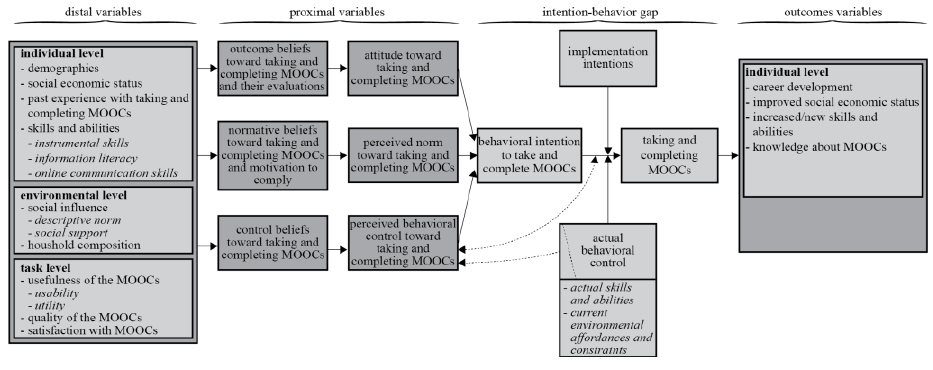
Figure 1 : Research model of the MOOCKnowledge project Background variables are usually referred to as distal variables whereas the different variables that directly influence intention are referred to as proximal variables. Distal variables in our model exist on an individual level, a social level, and a task level. These are for example demographic data, the socio-economic status of the participants, their lifelong learning profile, previous experiences with open online courses and IT competences. The reasoned action approach identifies attitude, perceived norm, and perceived behaviour control (i.e., self-efficacy) as proximal variables as they directly predict behavioral intention. Attitude is the person’s favourable or unfavourable position as regards taking a MOOC. Attitude is generally formed by the outcome beliefs of a person and his/her evaluation of these beliefs. For example, a person may belief that taking a MOOC will give her/him more opportunities in the labour market and evaluate this as very important for that person. Consequently, the person may have a positive attitude towards taking a